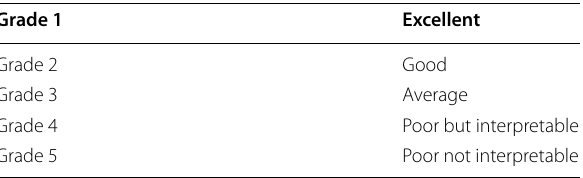
Table 2 Description of different grades for the assessment of image